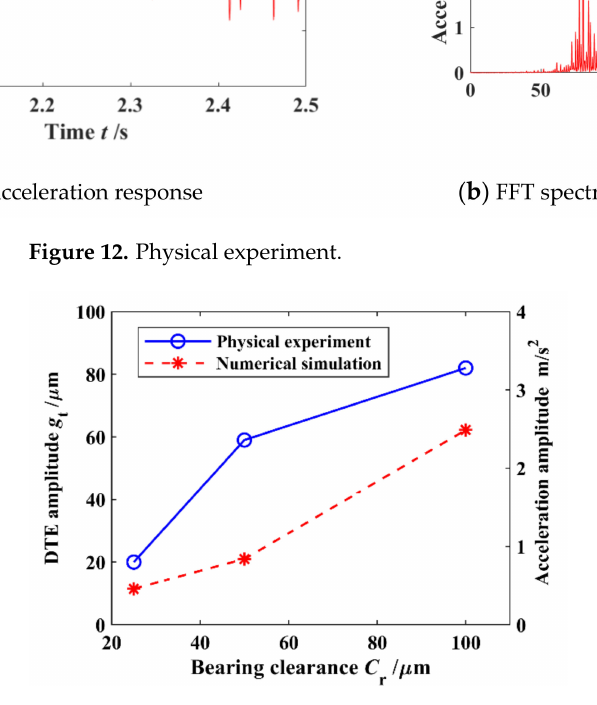
Figure 13. Amplitude of different bearing